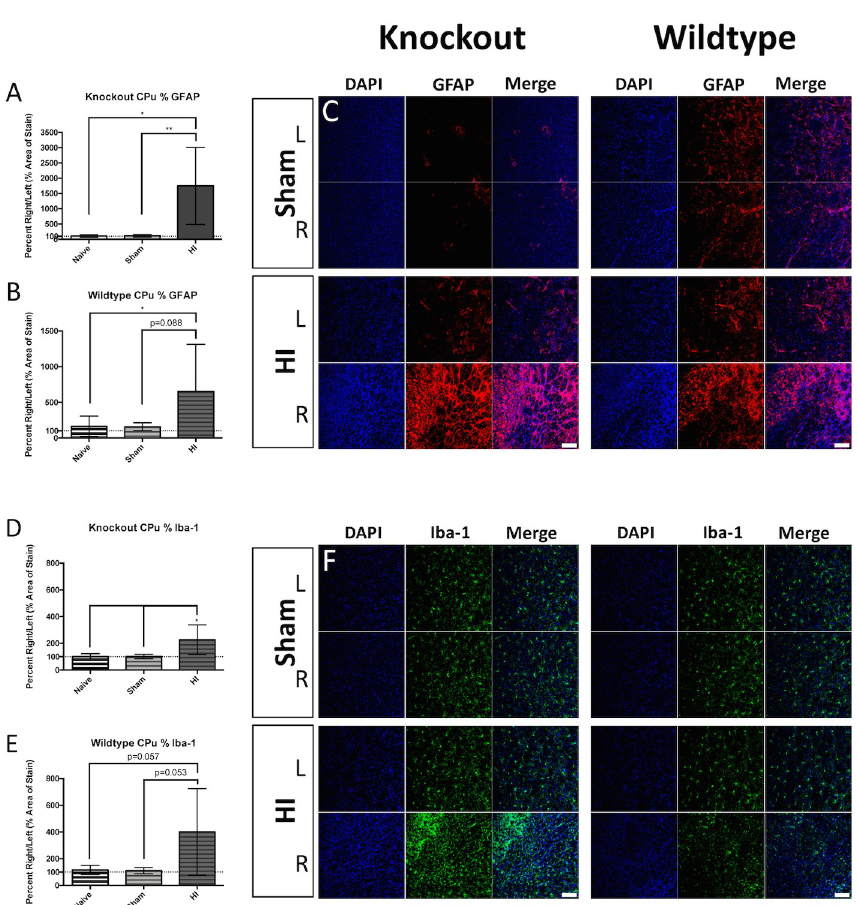
Fig 6. Caudate-putamen gliosis. KO injured animals displayed a significant increase in the percent area occupied by GFAP-positive signal when compared to uninjured controls (A), and WT injured animals trended toward similar results (B). Representative immunofluorescence is depicted for KO Sham (C top left), KO injured (C bottom left), WT Sham (C top right), and WT injured (C bottom right) in the right and left hemispheres (blue = DAPI, red = GFAP); Percent area occupied by Iba-1-positive staining was elevated in KO injured animals when compared to uninjured controls (D), and WT injured animals trended toward similar results (E). Representative immunofluorescence is depicted for KO Sham (F top left), KO injured (F bottom left), WT Sham (F top right), and WT injured (F bottom right) in the right and left hemispheres (blue = DAPI, green = Iba-1); Scale bars = 100 μ m, 20x. Error bars = ± SD. � p < 0.05, �� p <